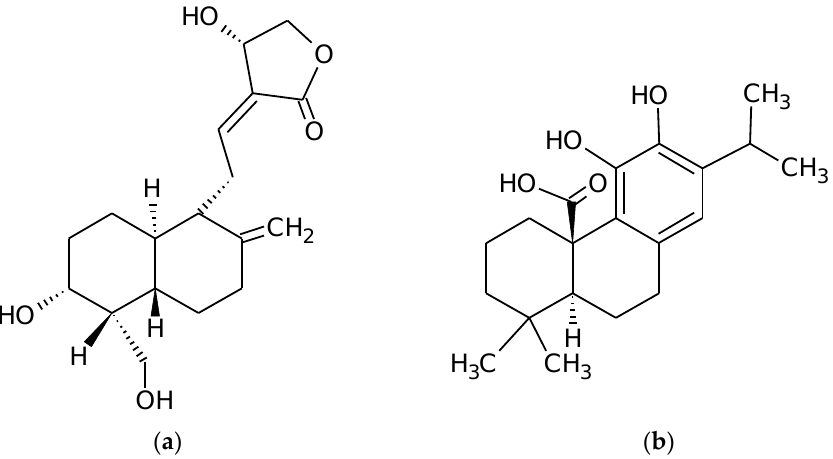
Figure 3. Chemical formula of ( a ) Andrographolide (Andro) and ( b ) carnosic acid (CA). In a transgenic mouse model (J20 Tg) with mild AD phenotype expression (high levels of amyloid aggregates), presymptomatic administration of Andro prevented the reduction of cellular energy metabolism markers, improved cognitive performance, restored the deficiencies at the synaptic level, and restored the length of synapses. Of note, Andro is a canonical Wnt signaling activator. Wnt signaling is a pathway involved in sev- eral processes during the development and maintenance of the adult central nervous sys- tem. The loss of Wnt signaling function has been associated with neuronal dysfunction in AD. The data obtained in the J20 Tg mouse model support the idea that the Andro activa- tion of Wnt signaling during presymptomatic stages could represent an interesting phar- macological strategy to delay the onset of AD [97].